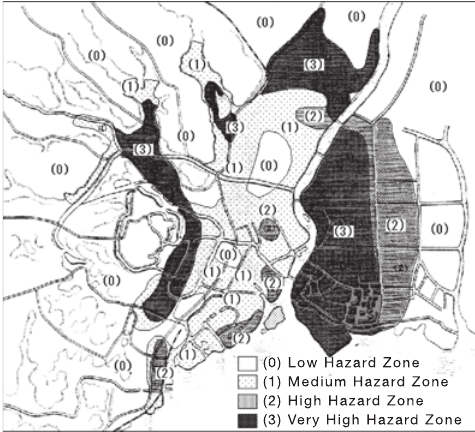
Fig. 1. Seismic microzoning map of Tokyo (Ima- mura, 1913).